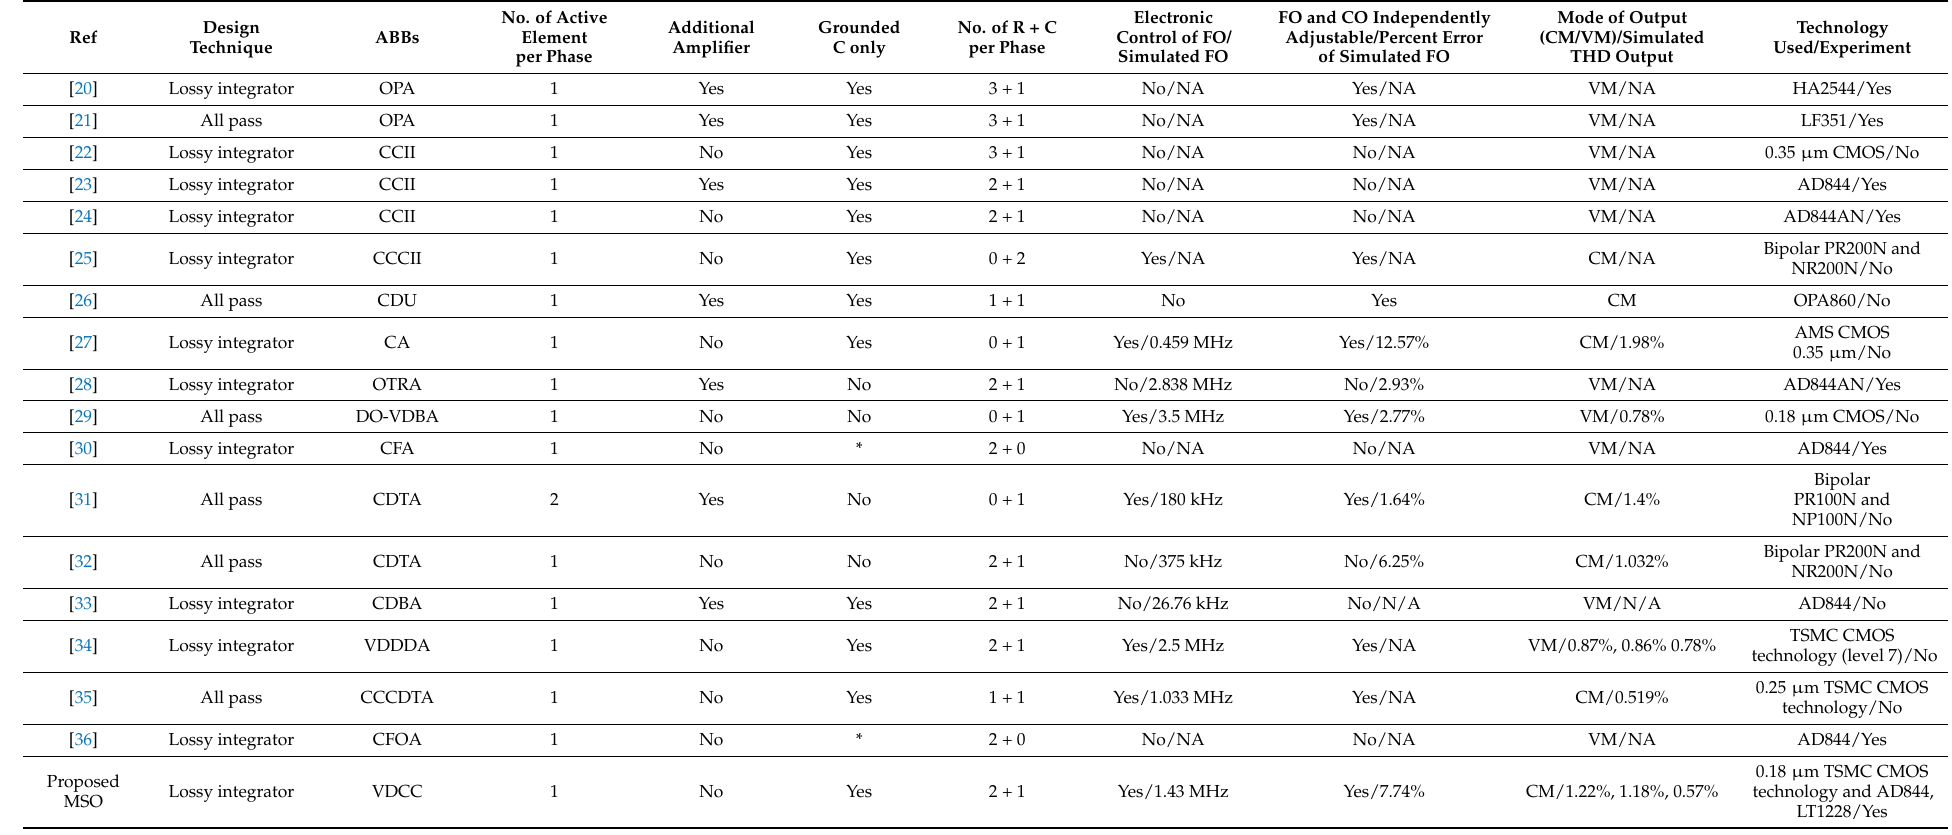
Table 1. Comparison of relevant